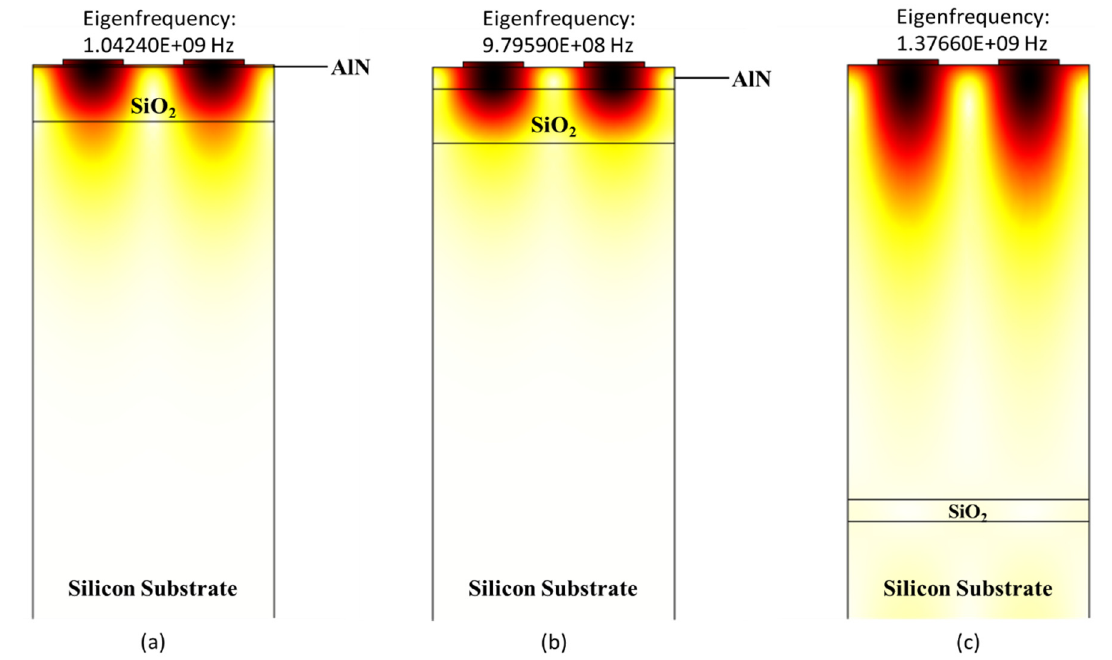
Figure 6. Zoom-in view of wave confinement and displacement profiles of structure C (AlN/SiO 2 /Si) in Rayleigh mode with normalized thickness of AlN ( a ) 0.01, ( b ) 0.1 and ( c ) 2.